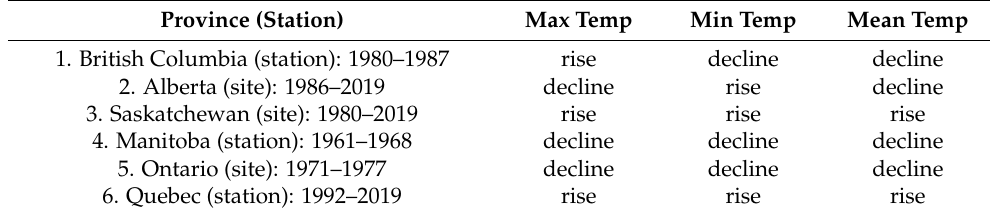
Table 4. Temperatures in the six Canadian provinces (sites) over the years.